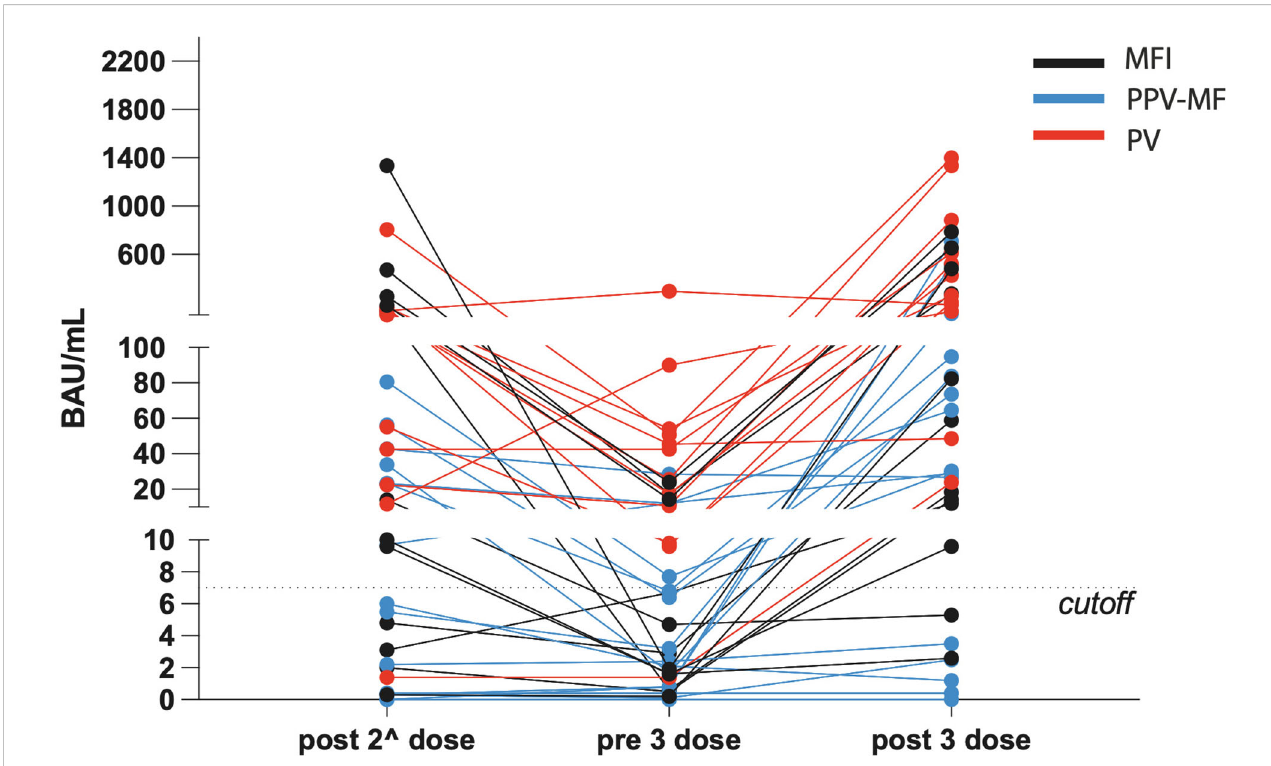
FIGURE 1 Levels of antibodies against SARS-CoV-2, expressed in BAU/mL, in the context of polycythemia vera, primary and secondary myelo fi brosis, during the different time